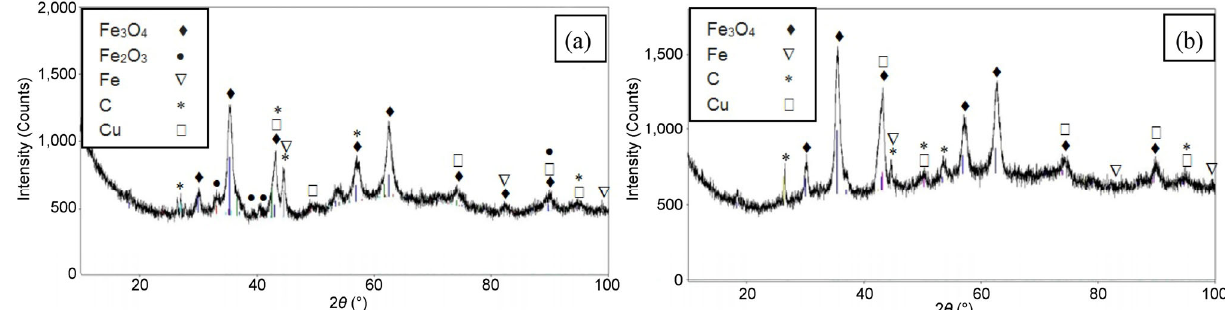
Fig. 6 XRD of airborne debris of (a) FM4-BD1 and (b) FM4-BD2